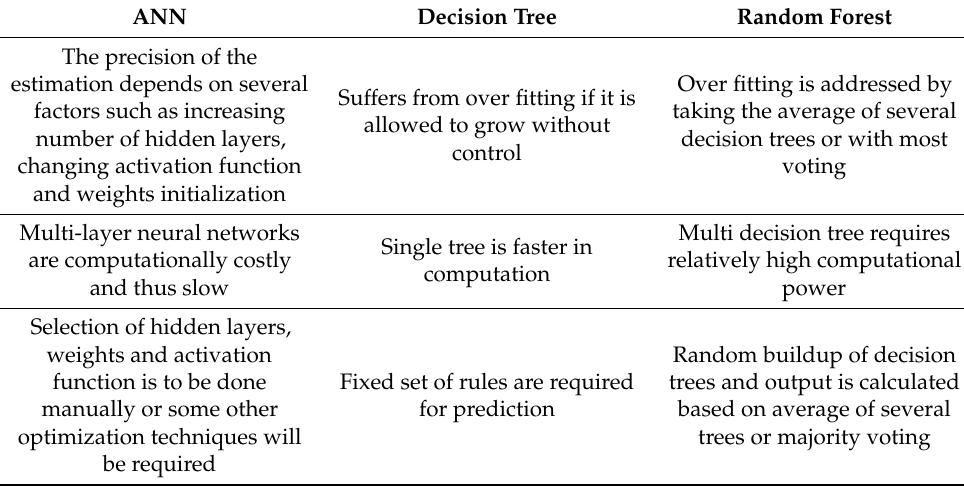
Table 1. Comparison of ANN, decision tree and Random Forest Algorithm. ANN Decision Tree Random Forest Over fitting is addressed by taking the average of several decision trees or with control